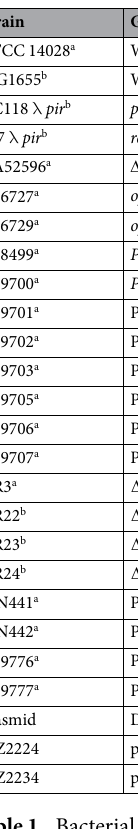
Table 1. Bacterial strains and plasmids. a S. enterica ; b E . coli